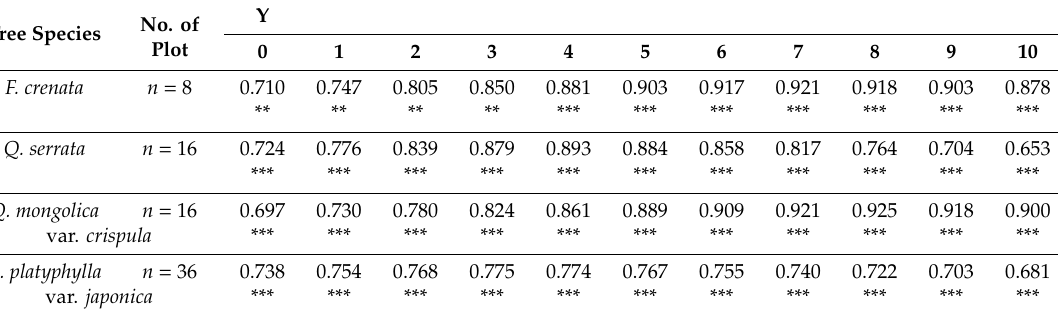
Table 4. The R 2 value for the linear regression line between relative value of leaf-level Σ P n_est and phytotoxic O 3 dose (POD Y , Y: flux threshold) in the leaves of F. crenata , Q. serrata , Q. mongolica var. crispula and B. platyphylla var. japonica